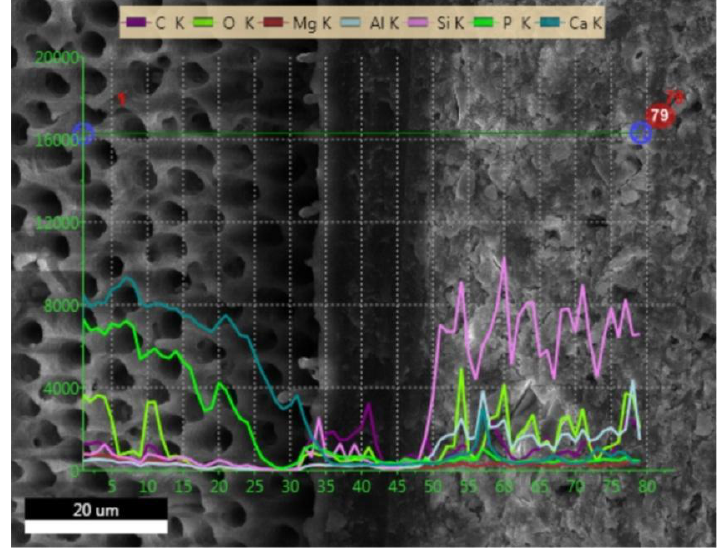
Figure 6. EDS line scan signals of individual elements present at dentin-resin interface obtained for Xeno V applied twice in 40 s (group 2A40).